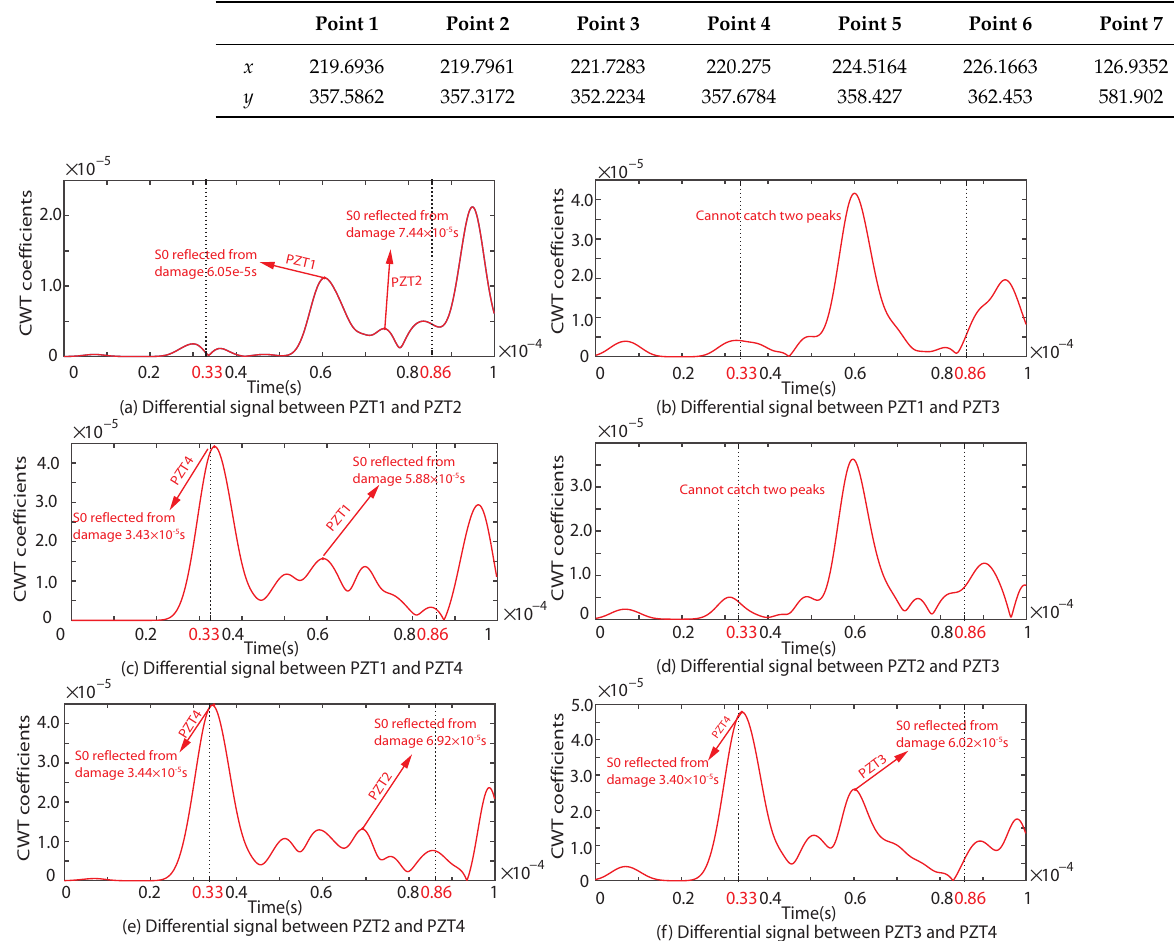
Figure 14. CWT coefficient of the difference signal of any two sensors in the experiment under Case